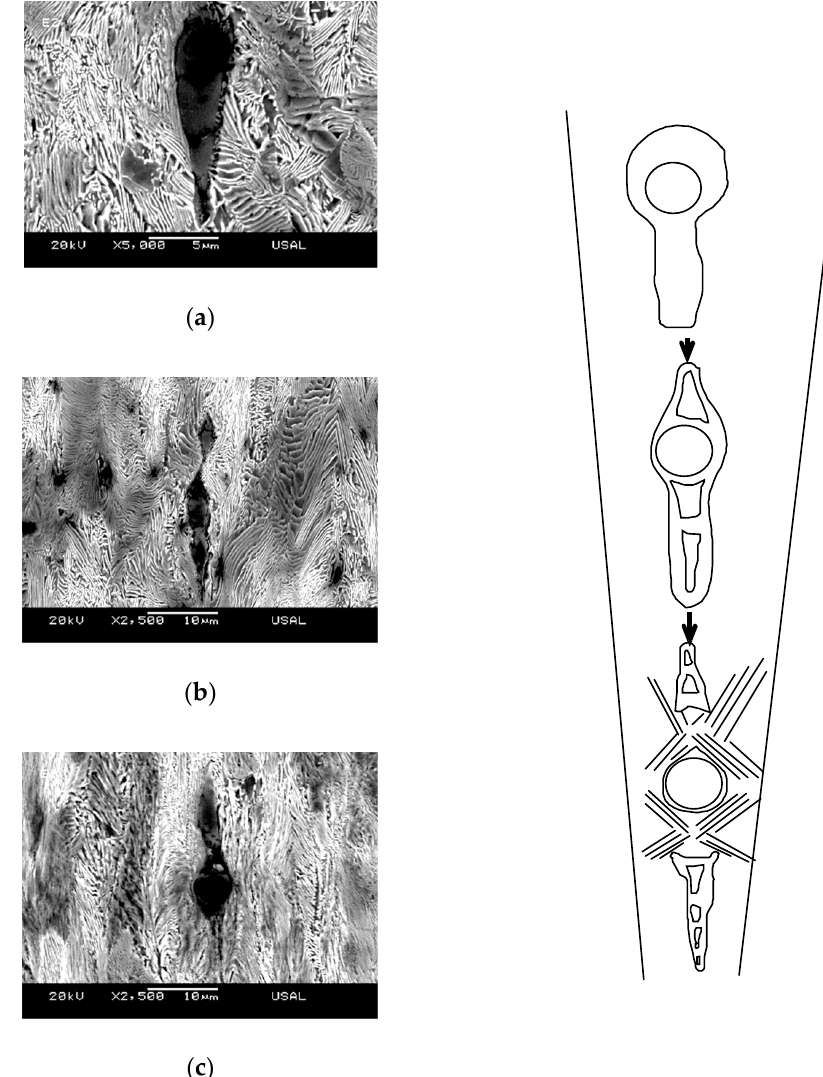
Figure 13. Micrographs and outline of the evolution of the inclusions of the mix -type during the drawing process belonging to steels E2 ( a ), E4 ( b ) and E6 ( c ).